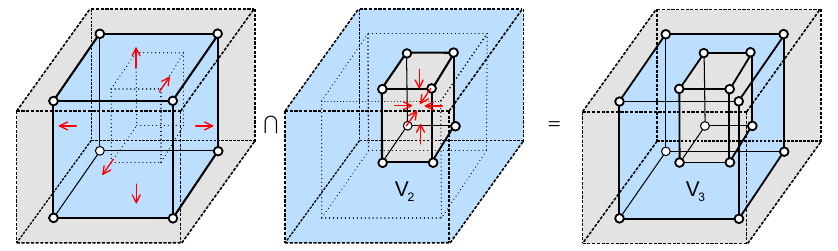
Figure 9. Multiply connected